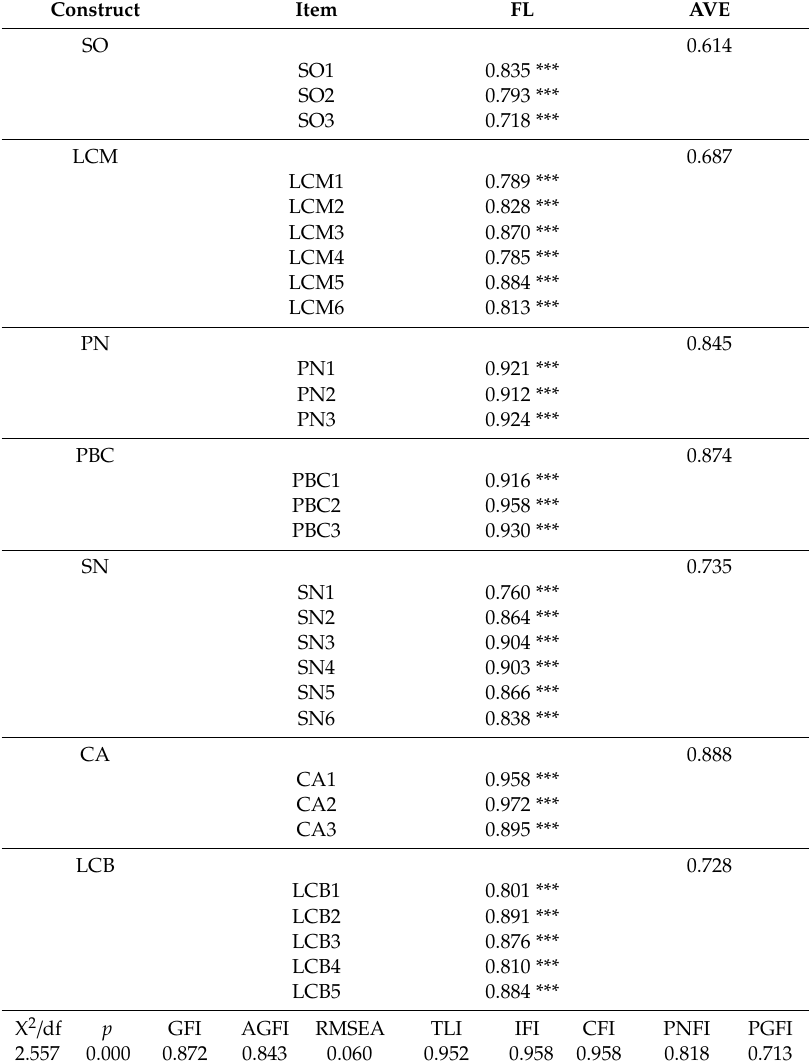
Table 8. Converged validity and goodness-of-fit of the measurement